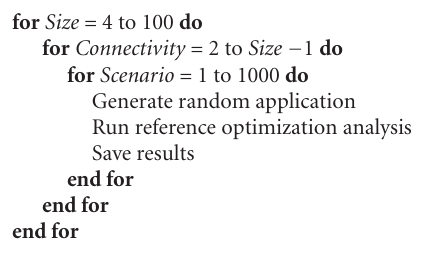
Algorithm 3: Statistical simulation script.